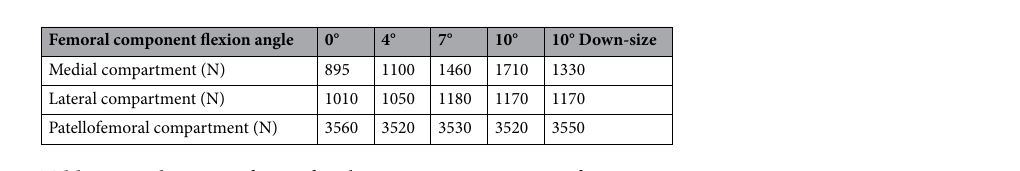
Table 1. Peak contact force of each compartment in Bi-Surface Knee.